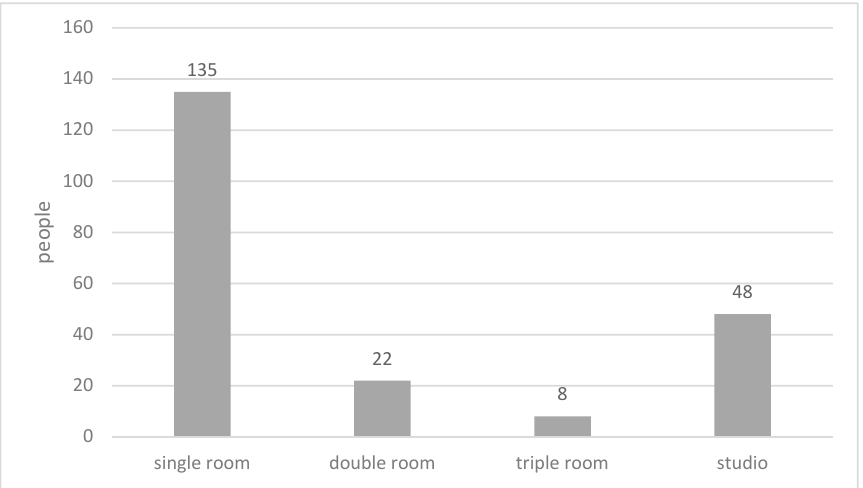
Figure 7. Preferred room types.